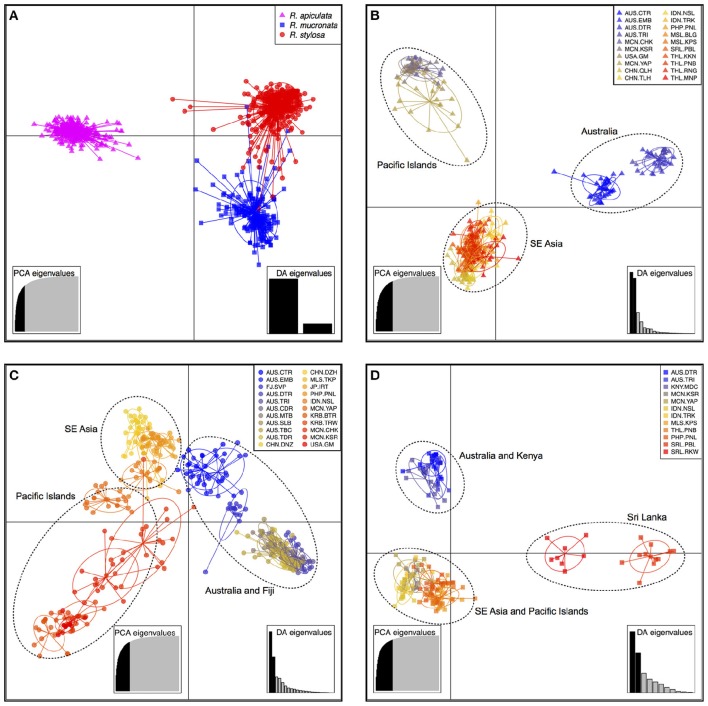
Plots of discriminant analysis of principal components (DAPC) for all species combined (A), R. apiculata (B), R. stylosa (C), and R. mucronata (D). Species and populations are shown by inertia ellipses and different shapes and colors as indicated in the top-right inset of each figure, and dots represent individuals.